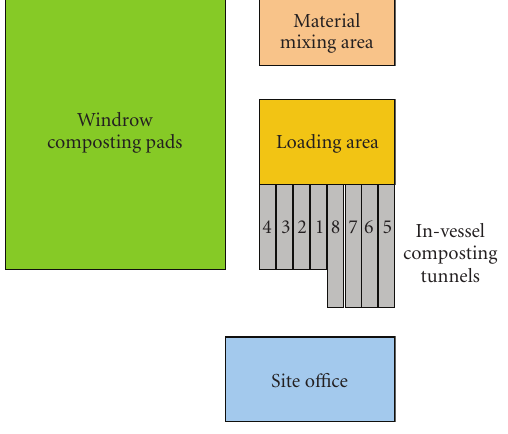
Figure 1: Deerdykes site